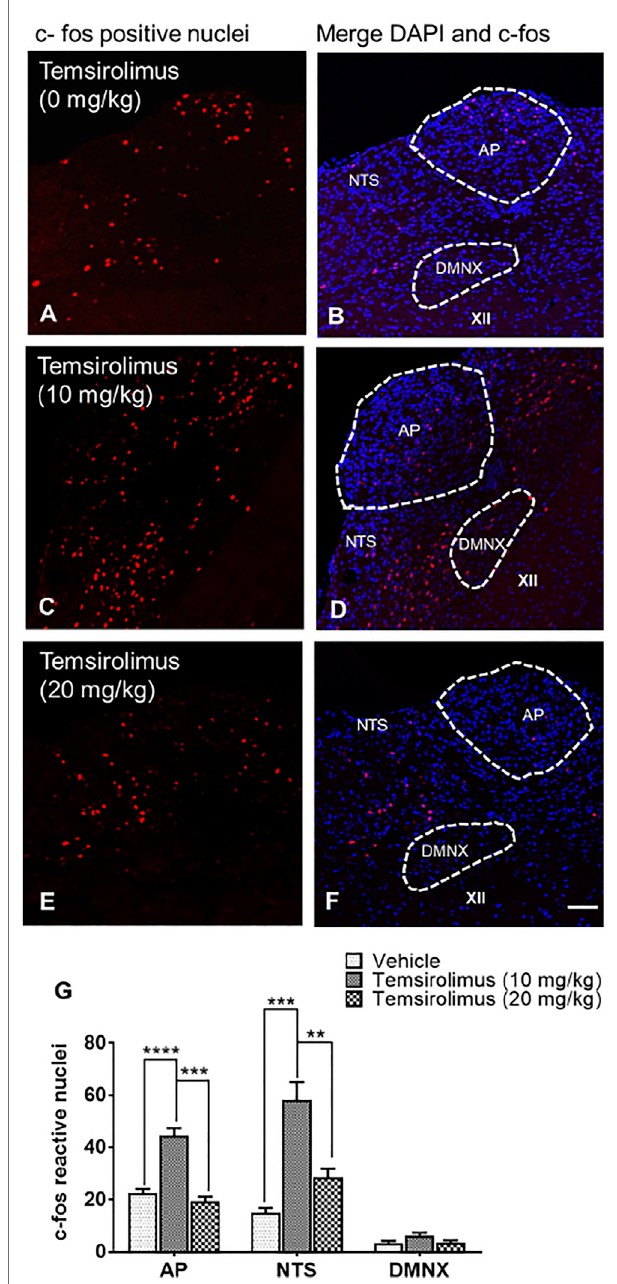
FIGURE 5 | Immunohistochemical analysis of c-fos induction in the shrew brainstem emetic nuclei following administration of either 0, 10, or 20 mg/kg temsirolimus. Brainstem sections (20 μ m) were prepared from different groups of shrews, including (A) vehicle-treated control and (C) 10 mg/kg (i.p.) and (E) 20 mg/kg (i.p.) dose of temsirolimus. Sections were immunolabeled with c-fos antibody overnight followed by Alexa